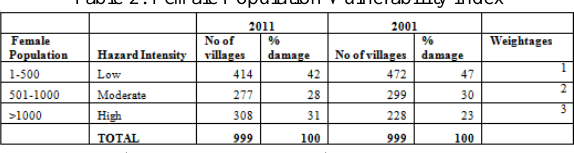
Table 2: Female Population Vulnerability Index